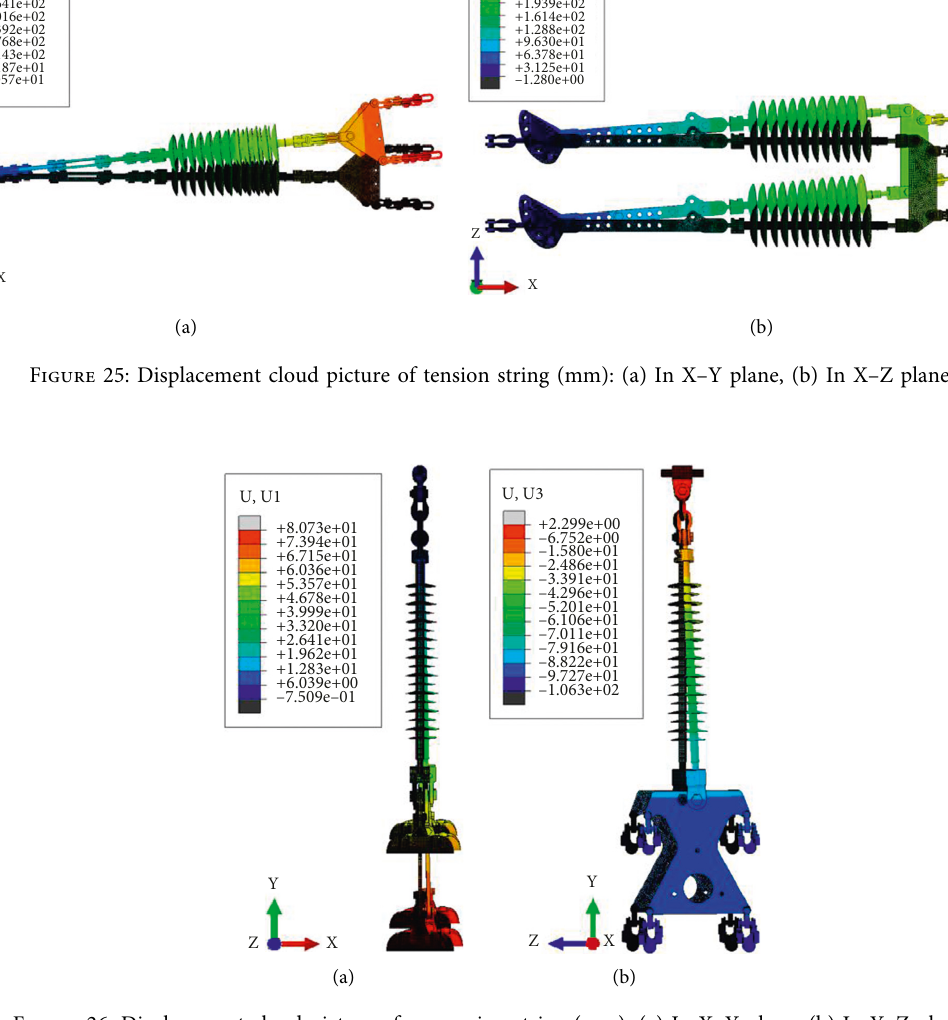
Figure 26: Displacement cloud picture of suspension string (mm): (a) In X–Y plane, (b) In Y–Z